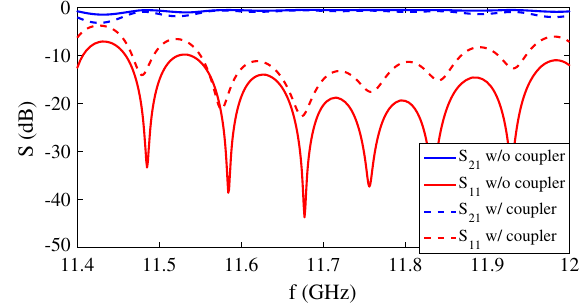
FIG. 5. Simulated S-parameters of the structure. The port definition is illustrated in Fig. 1: port 1 at the beam entrance; port 2 at the beam exit when simulated without the coupler (port 2a) or at the waveguide port when simulated with the coupler (port 2b).